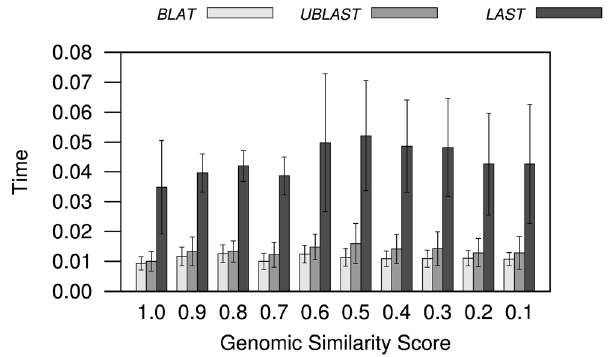
Figure 1. Difference in run time. Both UBLAST and BLAT ran in about a hundredth of the time as NCBI’s BLAST, while LAST ran in about a 25th of the time required for BLAST. Note: as in Figures 2 and 4, the bars represent averages for pairwise genome comparisons involving genomes binned at intervals of 0.1 of Genomic Similarity Score ( GSS ); the number of genomes at each GSS bin is not the same; and the error bars show standard deviations representing the variability of results among the genomes at each